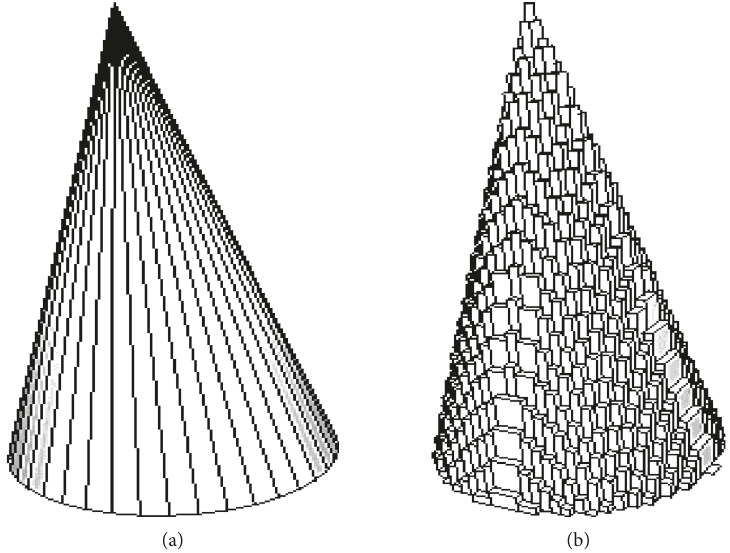
Figure 4: A cone expressed in the IFC data model and FDS